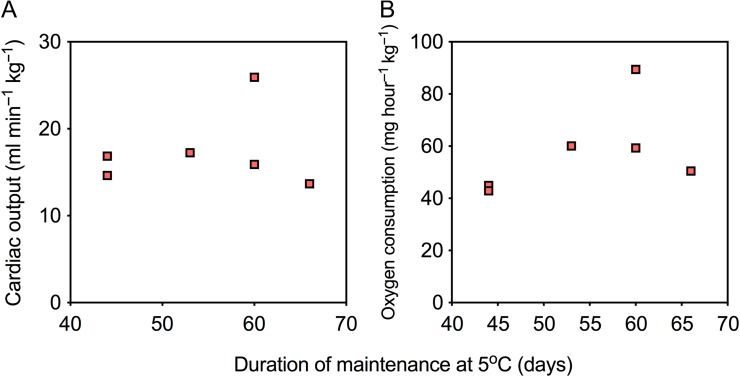
The relationships between acclimation duration and routine cardiac output (A) and oxygen consumption (B) at 5°C. As there were no significant effects of acclimation time on either variable, data for the 5°C acclimation group were pooled, irrespective of acclimation duration